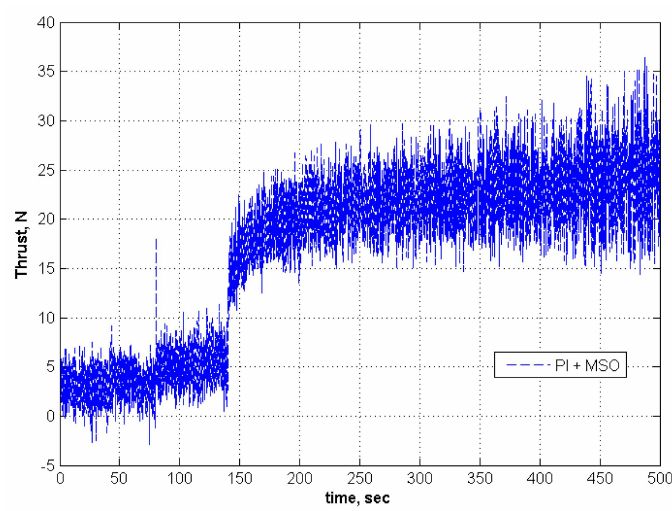
Figure 24. Thrust response for 50% C m α in the